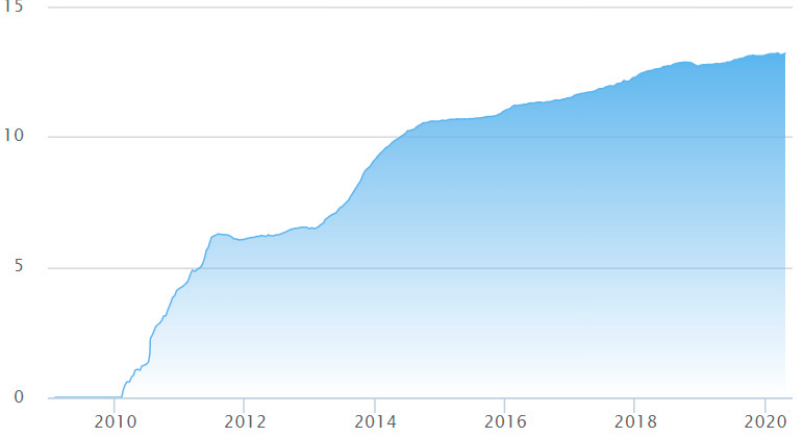
Figure 4. Logarithm scale of a block’s formation complexity. Source: https://www.btc.com.